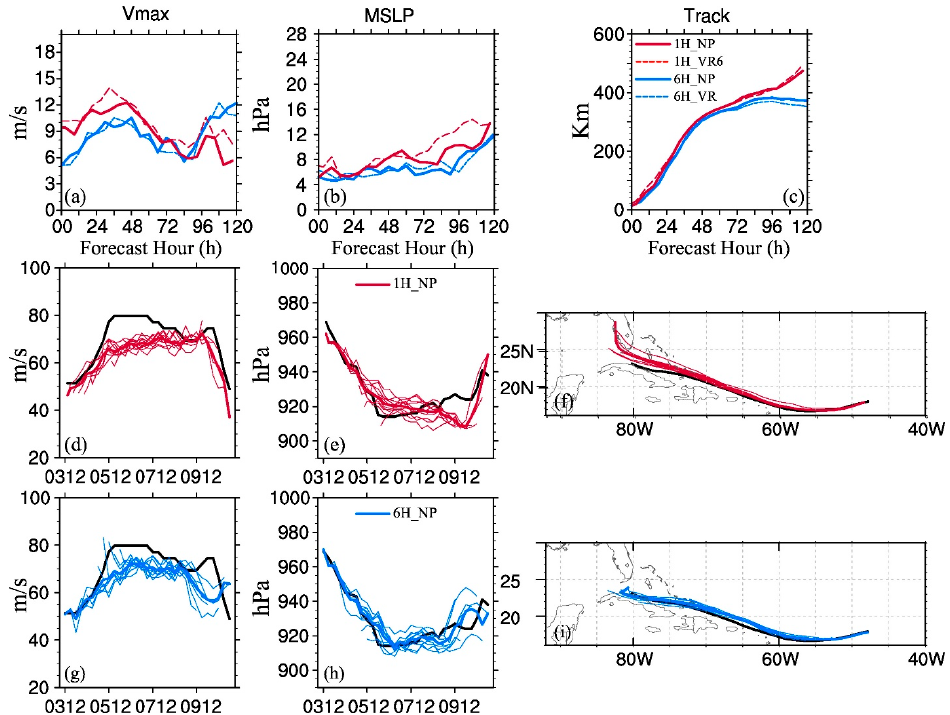
Figure 13. Same as Figure 2, except for “1H_NP” (solid red), “6H_NP” (solid turquoise), “1H_VR6” (dashed red), and “6H_VR” (dashed turquoise).